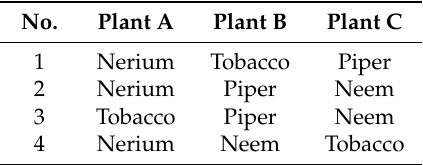
Table 3. Tri-herbal combinations of plant